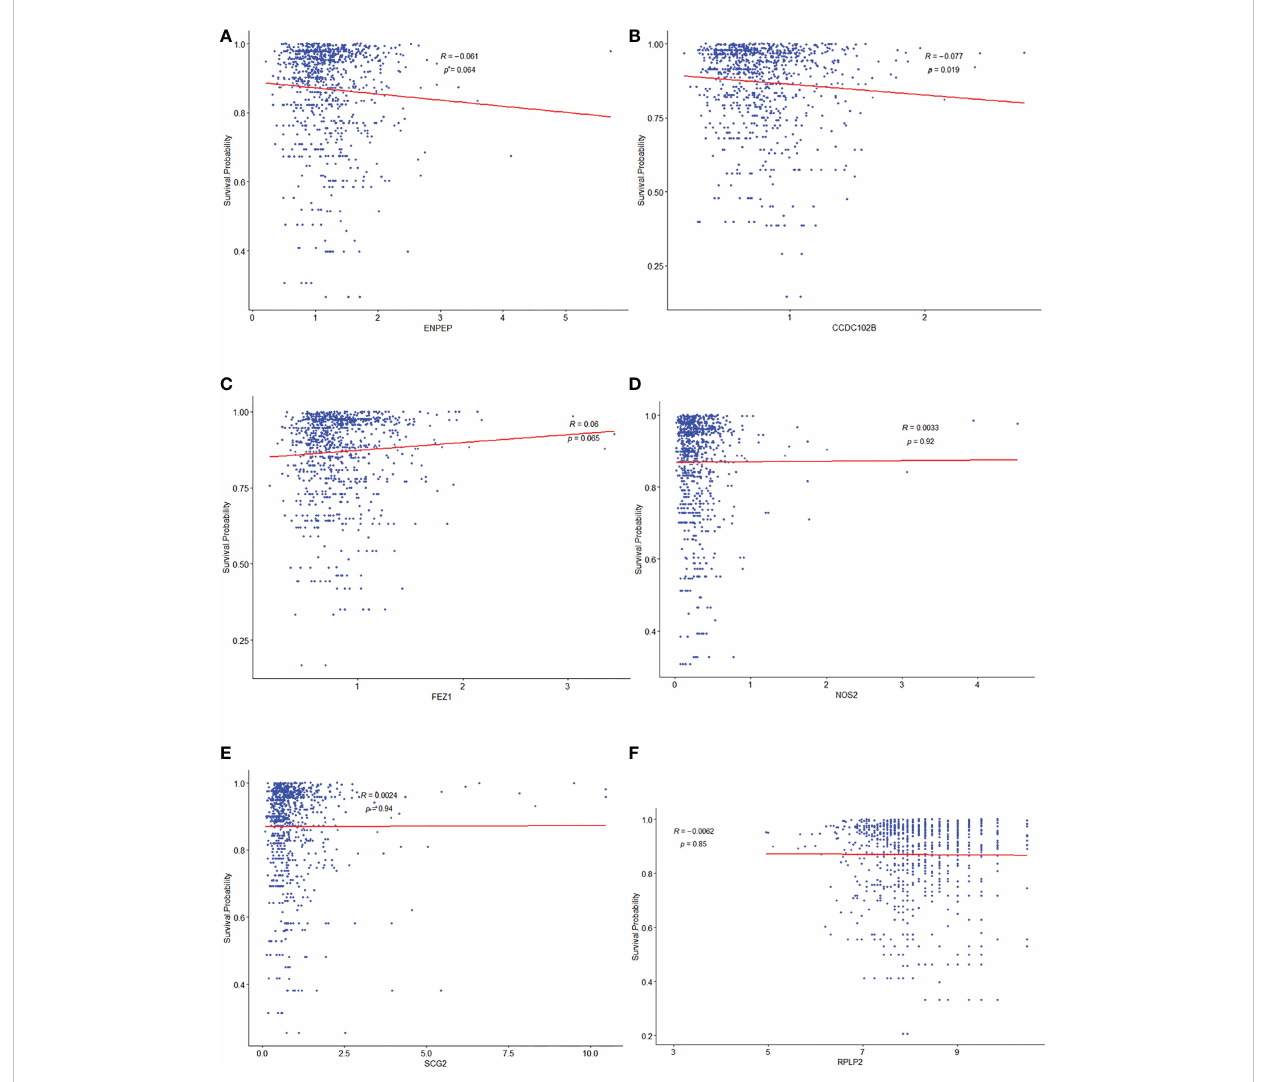
FIGURE 3 Correlationship between potential selected TME prognostic genes and prognosis of breast cancer patients. The relationship analysis between prognosis of breast cancer patients and ENPEP (A) , CCDC102B (B) , FEZ1 (C) , NOS2 (D) , SCG2 (E) , and RPLP2 (F) ,